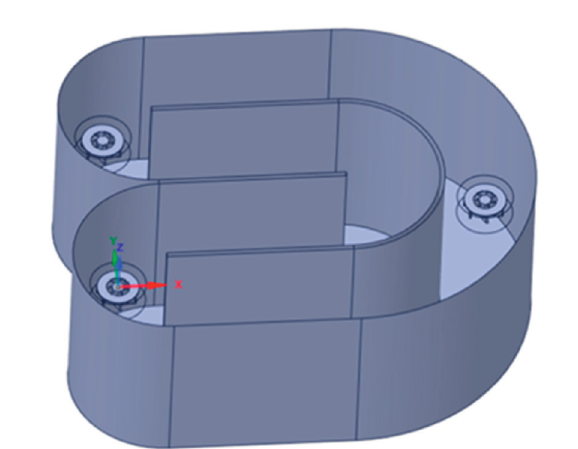
Figure 2: 3D model of the oxide ditch.